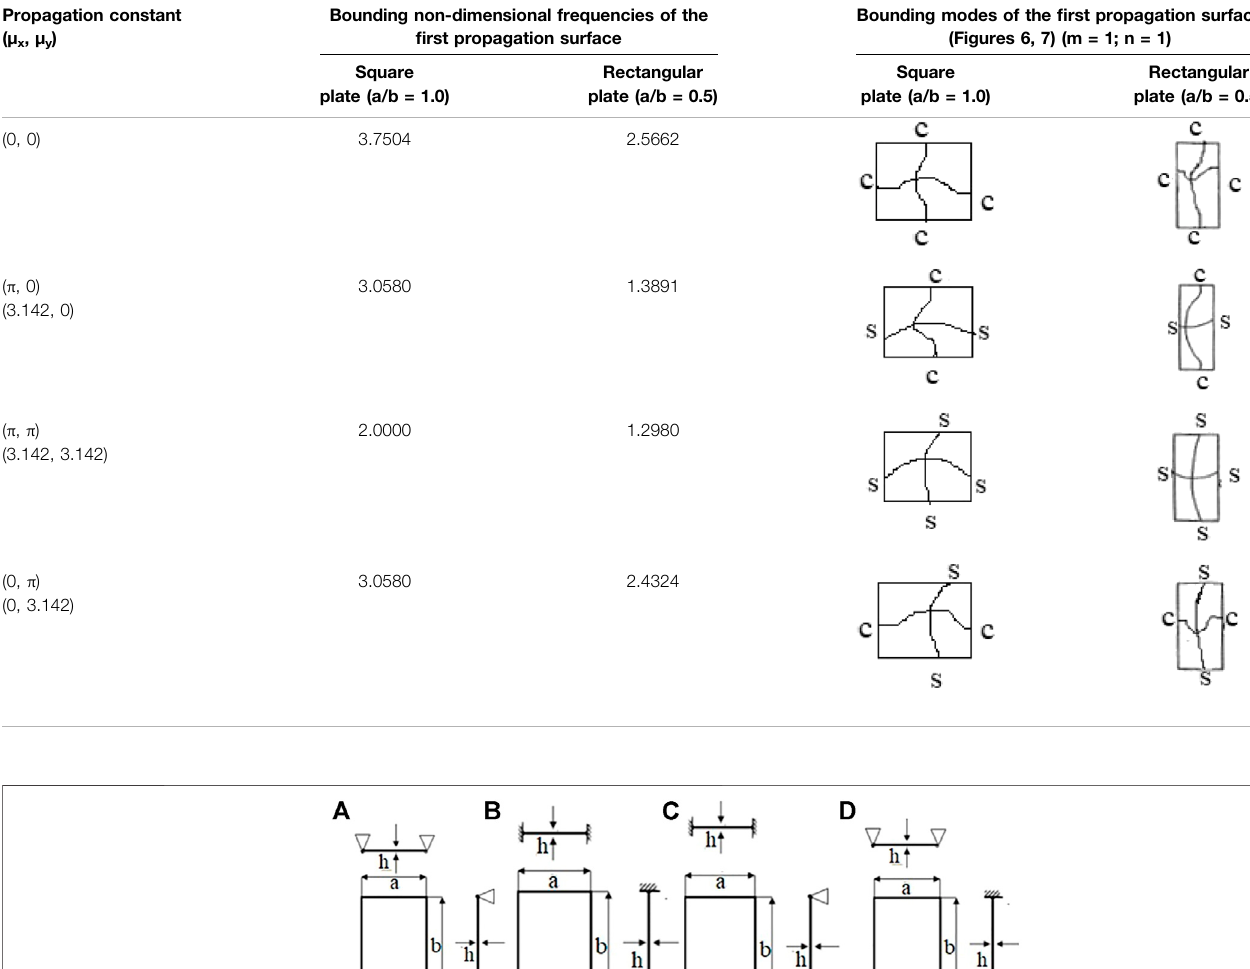
TABLE 3 | Nondimensional bounding frequencies and bounding modes of the periodic plate.